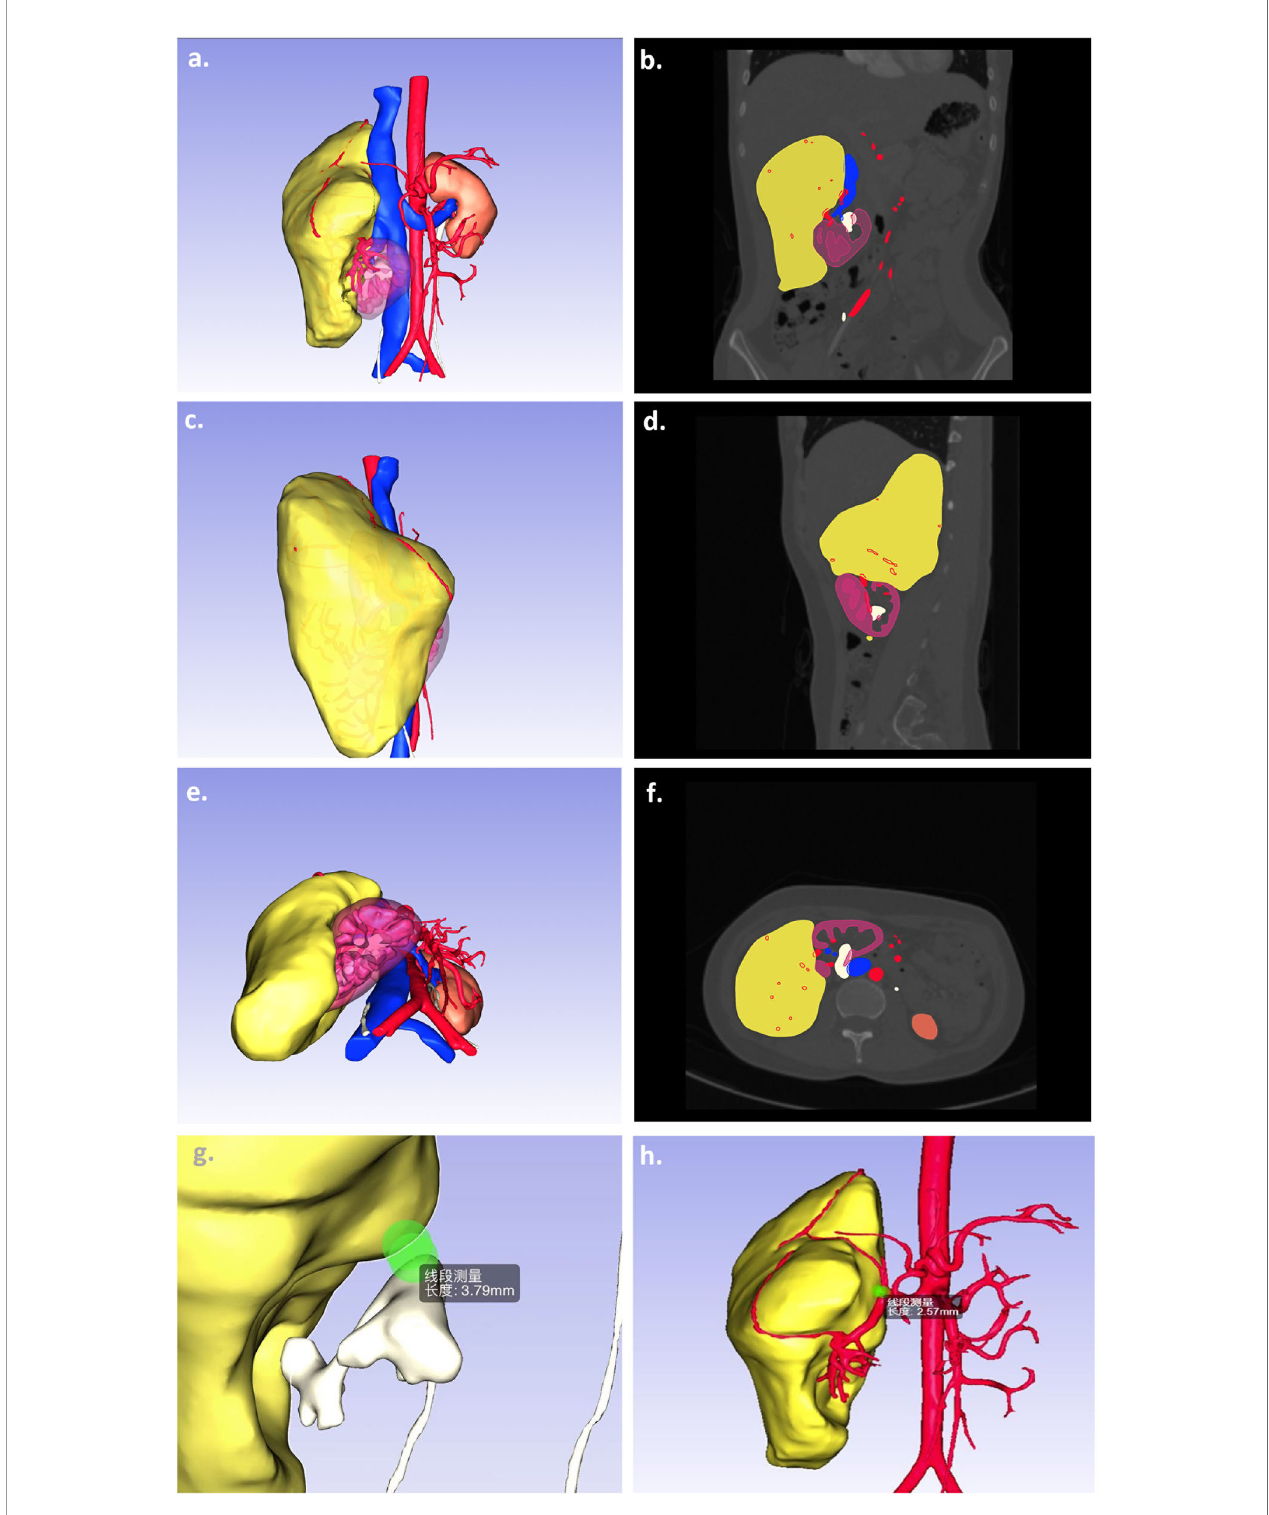
FIGURE 1 | A sample of 3D segmentation of giant sporadic renal angiomyolipoma. Computed tomography scans of kidney tumors show the kidney (purple), tumor (yellow), arteries (red), veins (blue), and collecting system (white) segmentations as overlays (A, C, E) . The images (B, D, F) present the corresponding 3D segmentations at different view positions. The other images demonstrated the important parameters, namely, the nearness of the tumor to collecting system (G) and the nearness of tumor to the second branch of renal artery (H) .